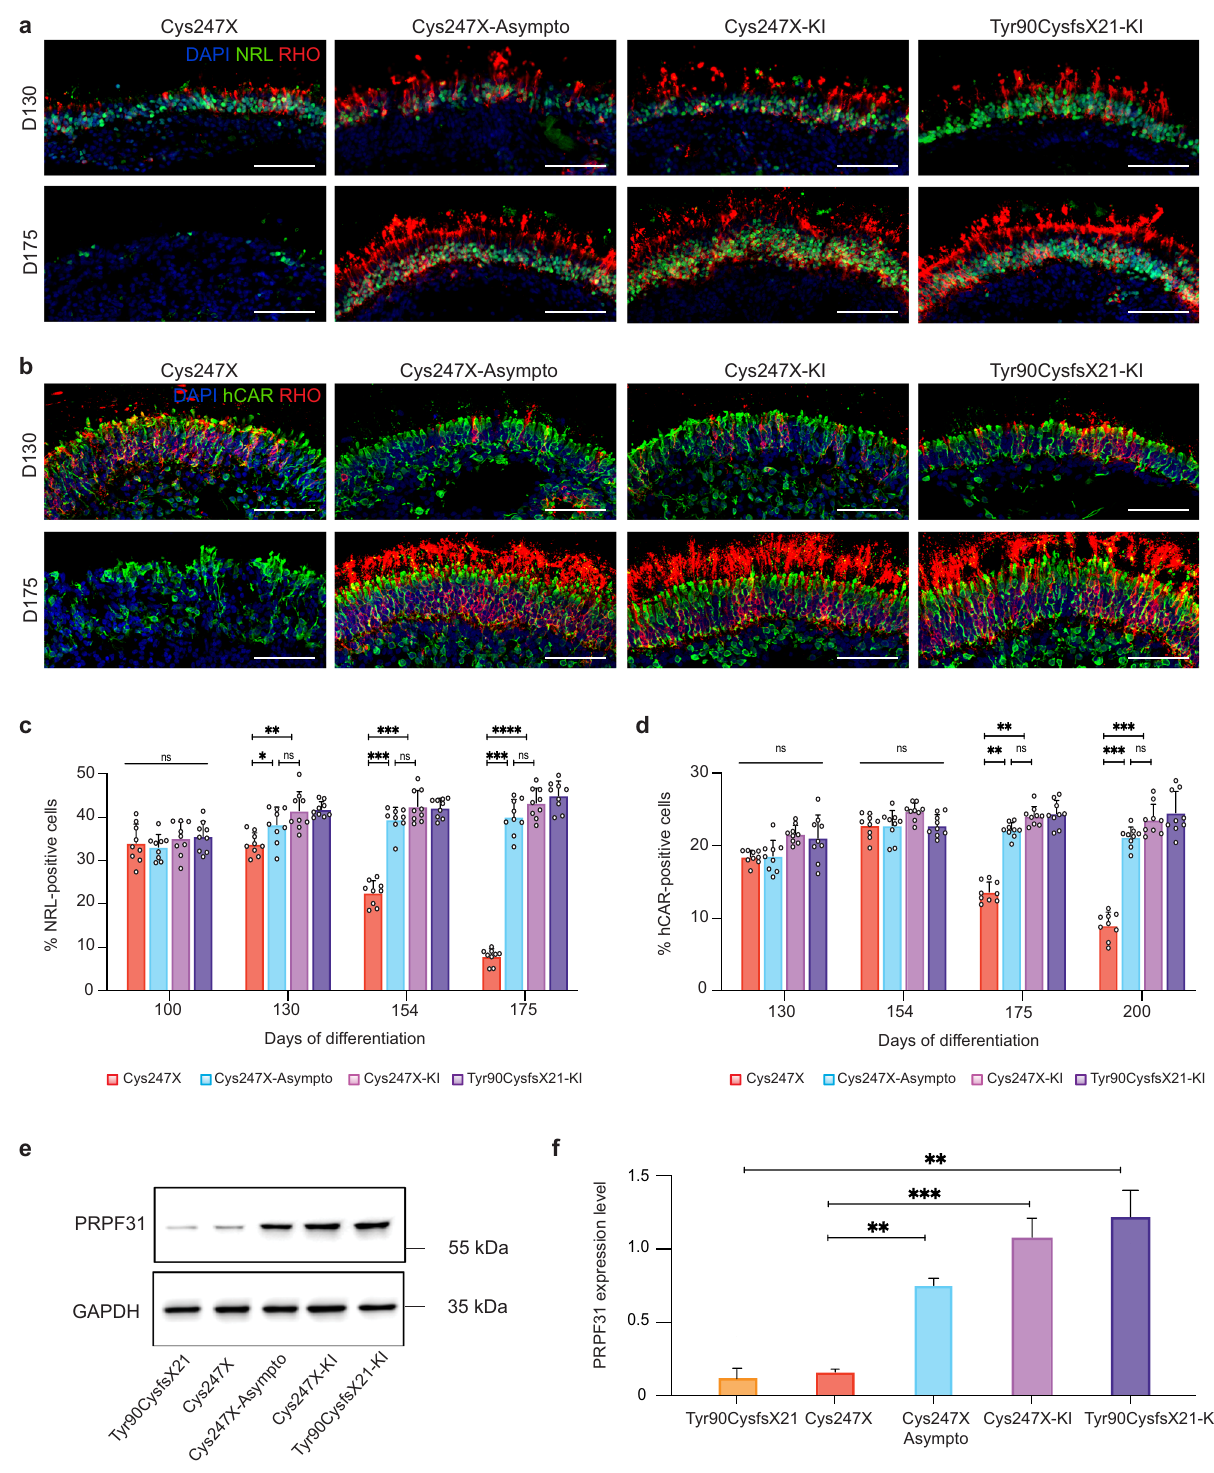
fi ltered out genes with a TPM value lower than 5 in one group to keep splicing events on genes expressed at a signi fi cant level in the target cells. As such, we identi fi ed 1049 differential splicing events corresponding to 600 unique genes (Fig. 11a and Supplementary Data 5). Among the fi ve types of events detected, a large majority corresponded either to exon skipping (38%) or to mutually exclusive exons (42%). GO enrichment analysis